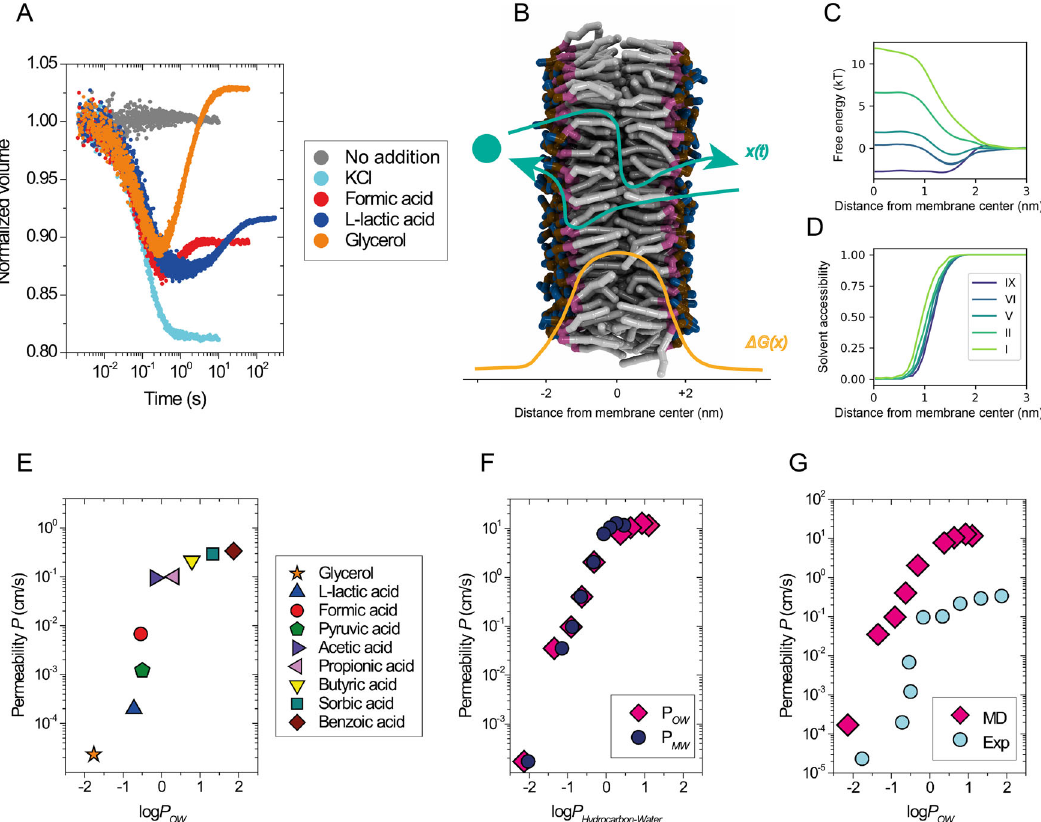
Fig. 1 Permeability of solutes as a function of their lipophilicity. A Overview of experimental assay. Kinetic data obtained with the calcein self-quenching assay using vesicles composed of DOPC mixed with buffer (gray) or osmotically shocked with 52.5 mM KCl (cyan), 50 mM sodium formate (red), 50 mM sodium L-lactate (blue) or 120 mM glycerol (orange) at 20 °C. B Schematic description of the permeation process, x(t) , through a lipid membrane with an example free energy pro fi le, Δ G(x) (lipid tails, gray; glycerol moiety, purple; phosphate moiety, ochre; and choline moiety, blue; water molecules are not shown). C Selected free energy pro fi les from simulations of solutes with varying hydrophobicity levels (I most hydrophilic, IX most hydrophobic) permeating through a DOPC lipid membrane as a function of the distance from the bilayer center along the membrane. Only one half of the whole symmetric permeation pro fi le is shown. D Solvent accessibility pro fi les of the permeating solutes along the permeation pathway. Solutes interact with solvent molecules even deep in the membrane tail region (x < 1.0 nm). E – G Permeability coef fi cients for DOPC membranes from experiments at 20 °C ( E , G ) and simulations ( F , G ) plotted against the logarithm of octanol/water (log P OW ) and membrane/water partitioning coef fi cient (log P MW ) of the solutes. Solutes of the hydrophobic levels I (log P OW = − 2.14) to IX (logP OW = 1.1) were used in the simulations. Log P is log 10 (partition coef fi cient), where P refers to the equilibrium distribution of a molecule between the hydrophobic and hydrophilic phase of two immiscible solvents. The experimental log P OW values for weak acids and glycerol ( E , G ) were taken from the PubChem database (https://pubchem.ncbi.nlm.nih.gov/). The simulated log P OW values ( F , G ) were taken from work 25 ; log P MW values ( F ) were obtained from the present simulations. The partition coef fi cients are related to the free energy difference between the respective phases. In the case of P MW , this is the difference between the membrane center and the solvent phase. The values of the free energy are presented in ( C ). The numerical values are presented in Supplementary Table log P OW for the hydrophobic and hydrophilic solutes is indepen- dently recovered in both methods. In particular, the difference between acetic acid (log P OW = − 0.17) and formic acid (log P OW = − 0.54) corresponds to approximately one order of magnitude change of their permeability from experiments, whereas a similar difference from propionic acid (log P OW = 0.33) to butyric acid (log P OW = 0.79) is re fl ected only by about a factor of 2 increase of the permeability. Interestingly, for the hydrophobic compounds log P MW from MD simulations is smaller than log P OW (Fig. 1F). This is mainly caused by non-vanishing interactions of the solutes with solvent molecules even below 1 nm from the membrane center (Fig. 1D), making the overall polarity of the lipid membrane interior generally higher than in bulk octanol.